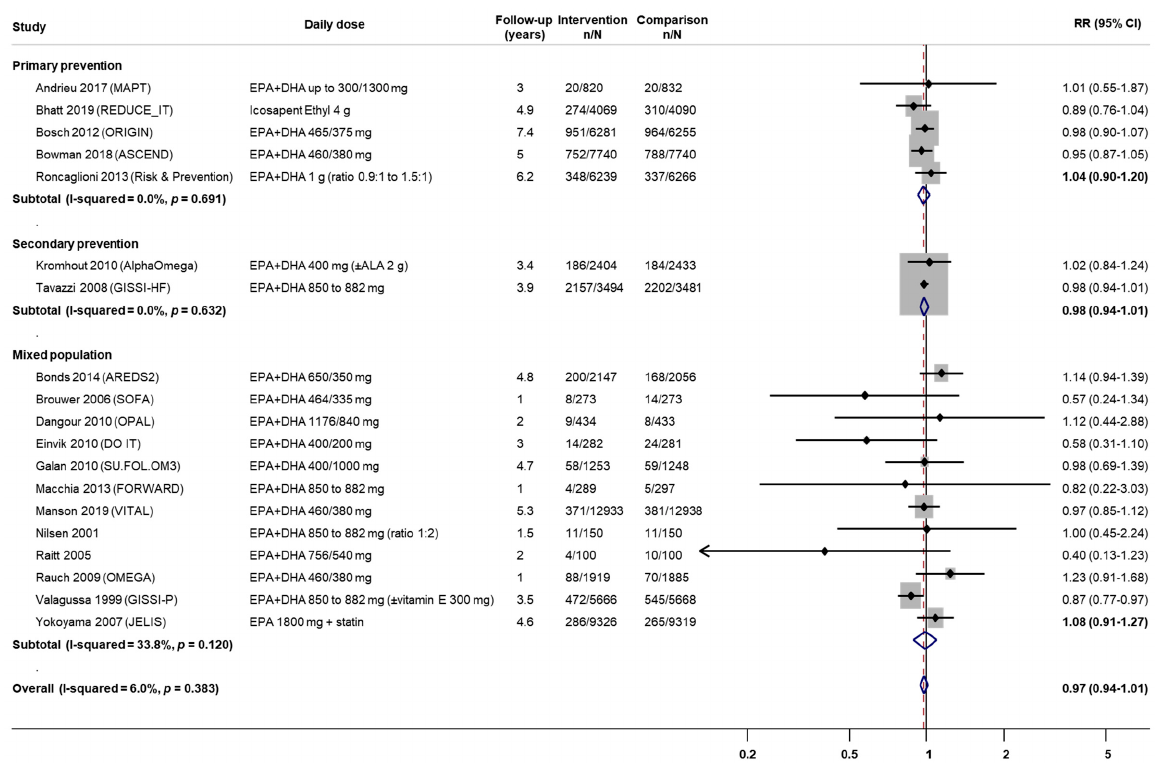
Figure A5. Subgroup meta-analysis for the effect of omega-3 supplementation on primary or secondary prevention of all-cause mortality. Full black quadrilateral represents the point estimate of individual studies and blank with quadrilateral represents pooled estimates. RR, relative risk; CI, confidence interval; EPA, eicosapentaenoic acid; DHA, docosahexaenoic acid. ALA: alpha-linolenic acid Bold font indicates statistical significance.